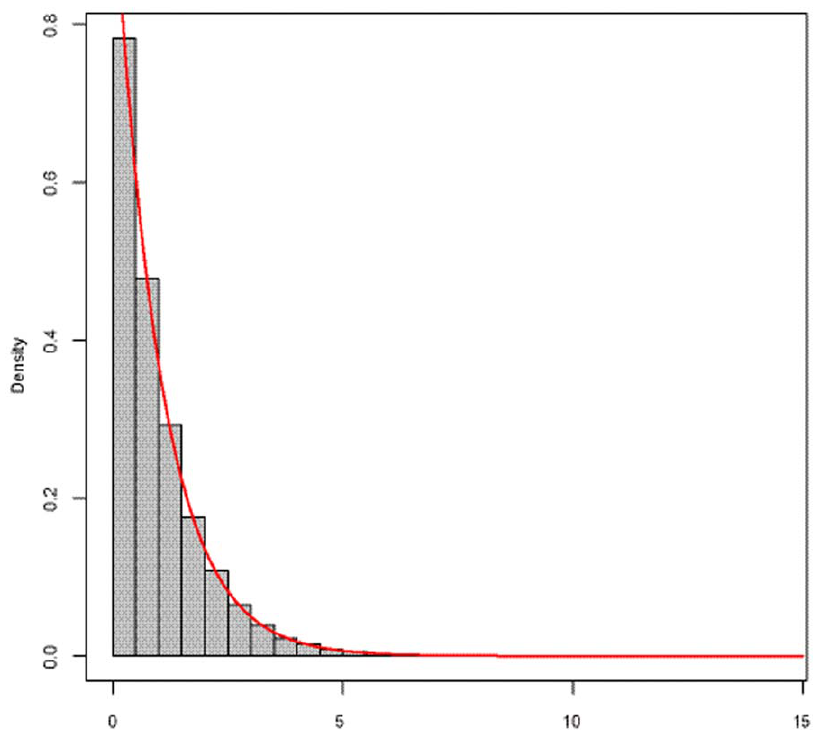
Figure 1. Frequency histogram of the Fst based statistic based on 10,000 simulations, compared with F (2, 3994). The gray bar denotes the frequency histogram of the Fst based statistic, corresponding to the null hypothesis that two SNPs are of no interaction. The red line is the density curve of the theoretical one.